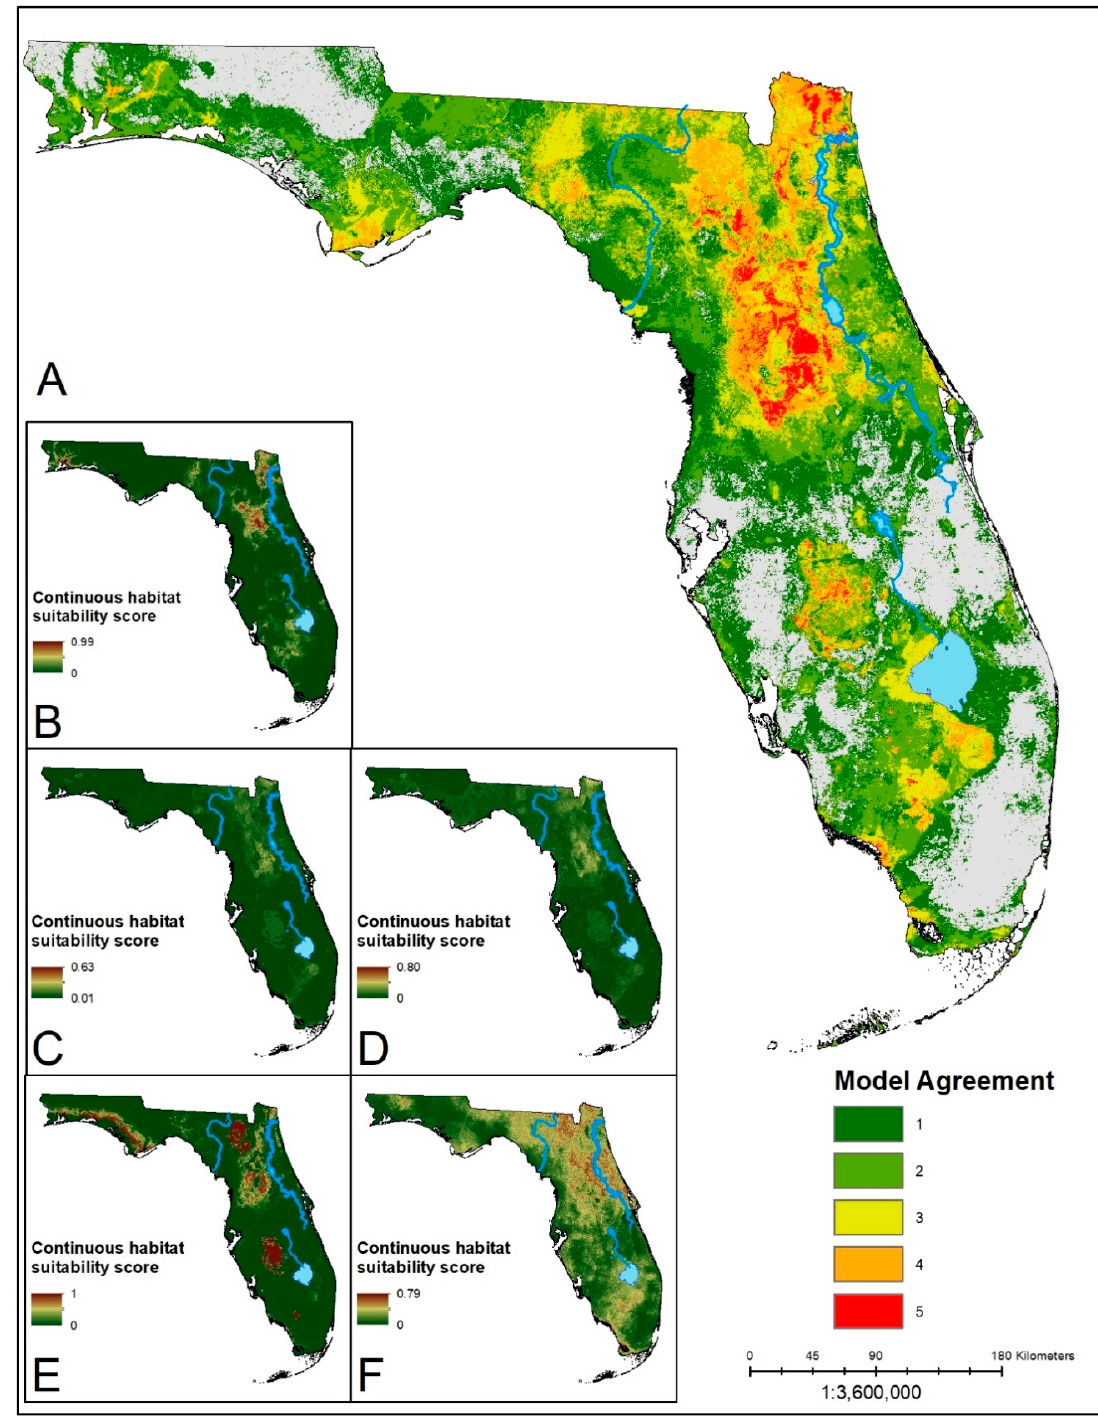
Figure 3. ( A ) Ensemble prediction of suitable habitat for D. variabilis . Hotter colors indicate